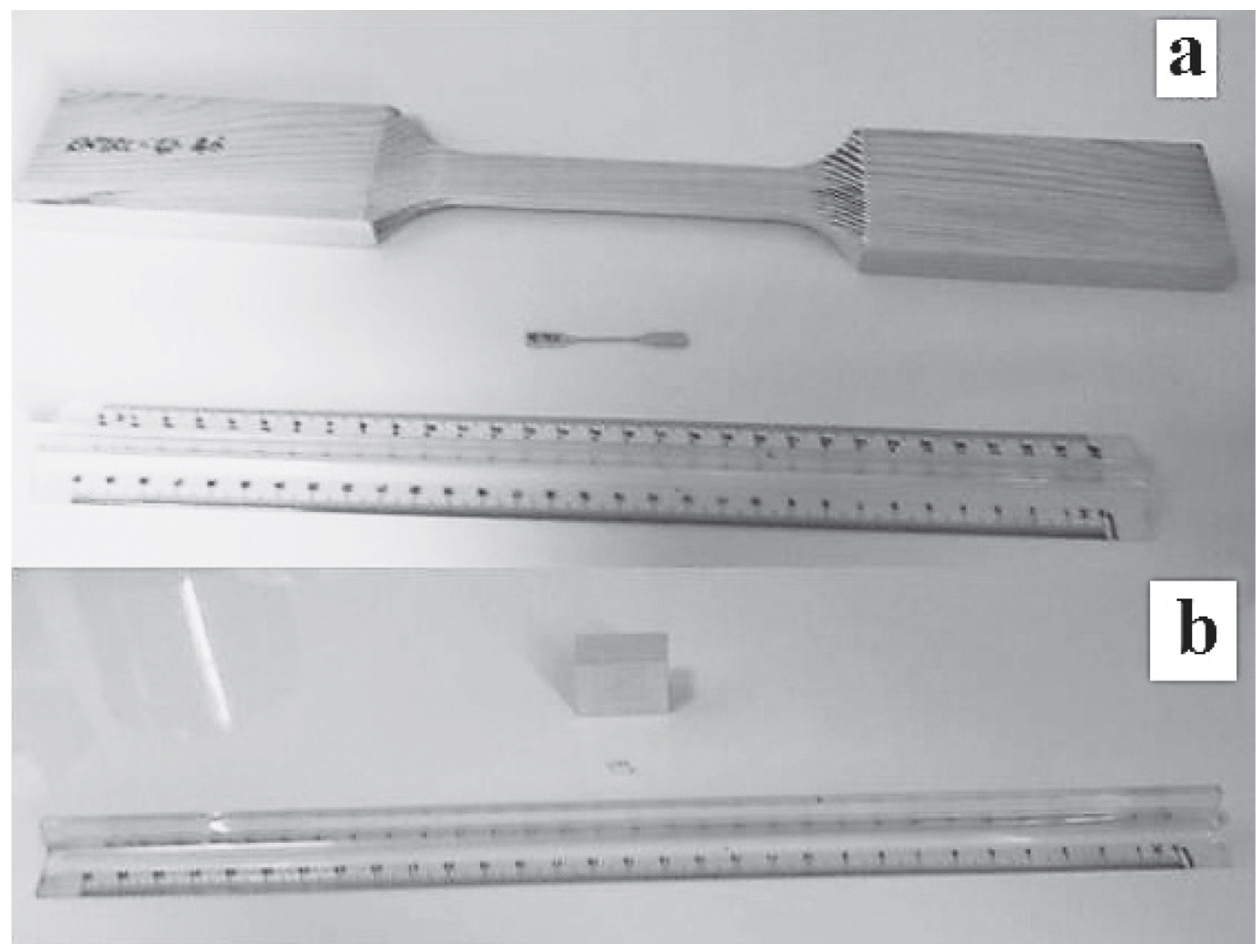
Figure 14. ( a ) Tensile and ( b ) compression specimens for investigating the size effect for wood. From [88].